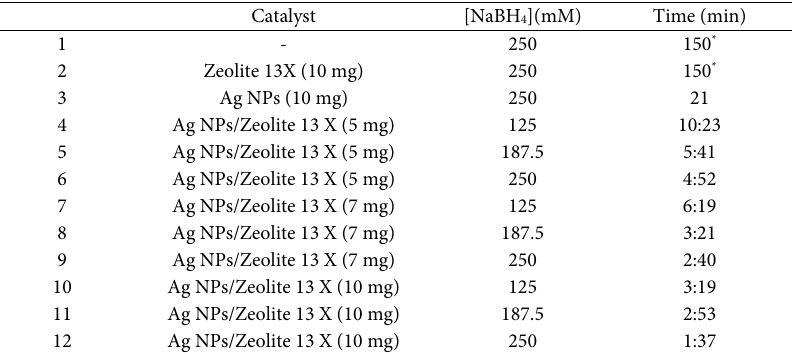
Table 1. Completion time for the reduction of 4-NP (2.5 mM) to 4-AP.